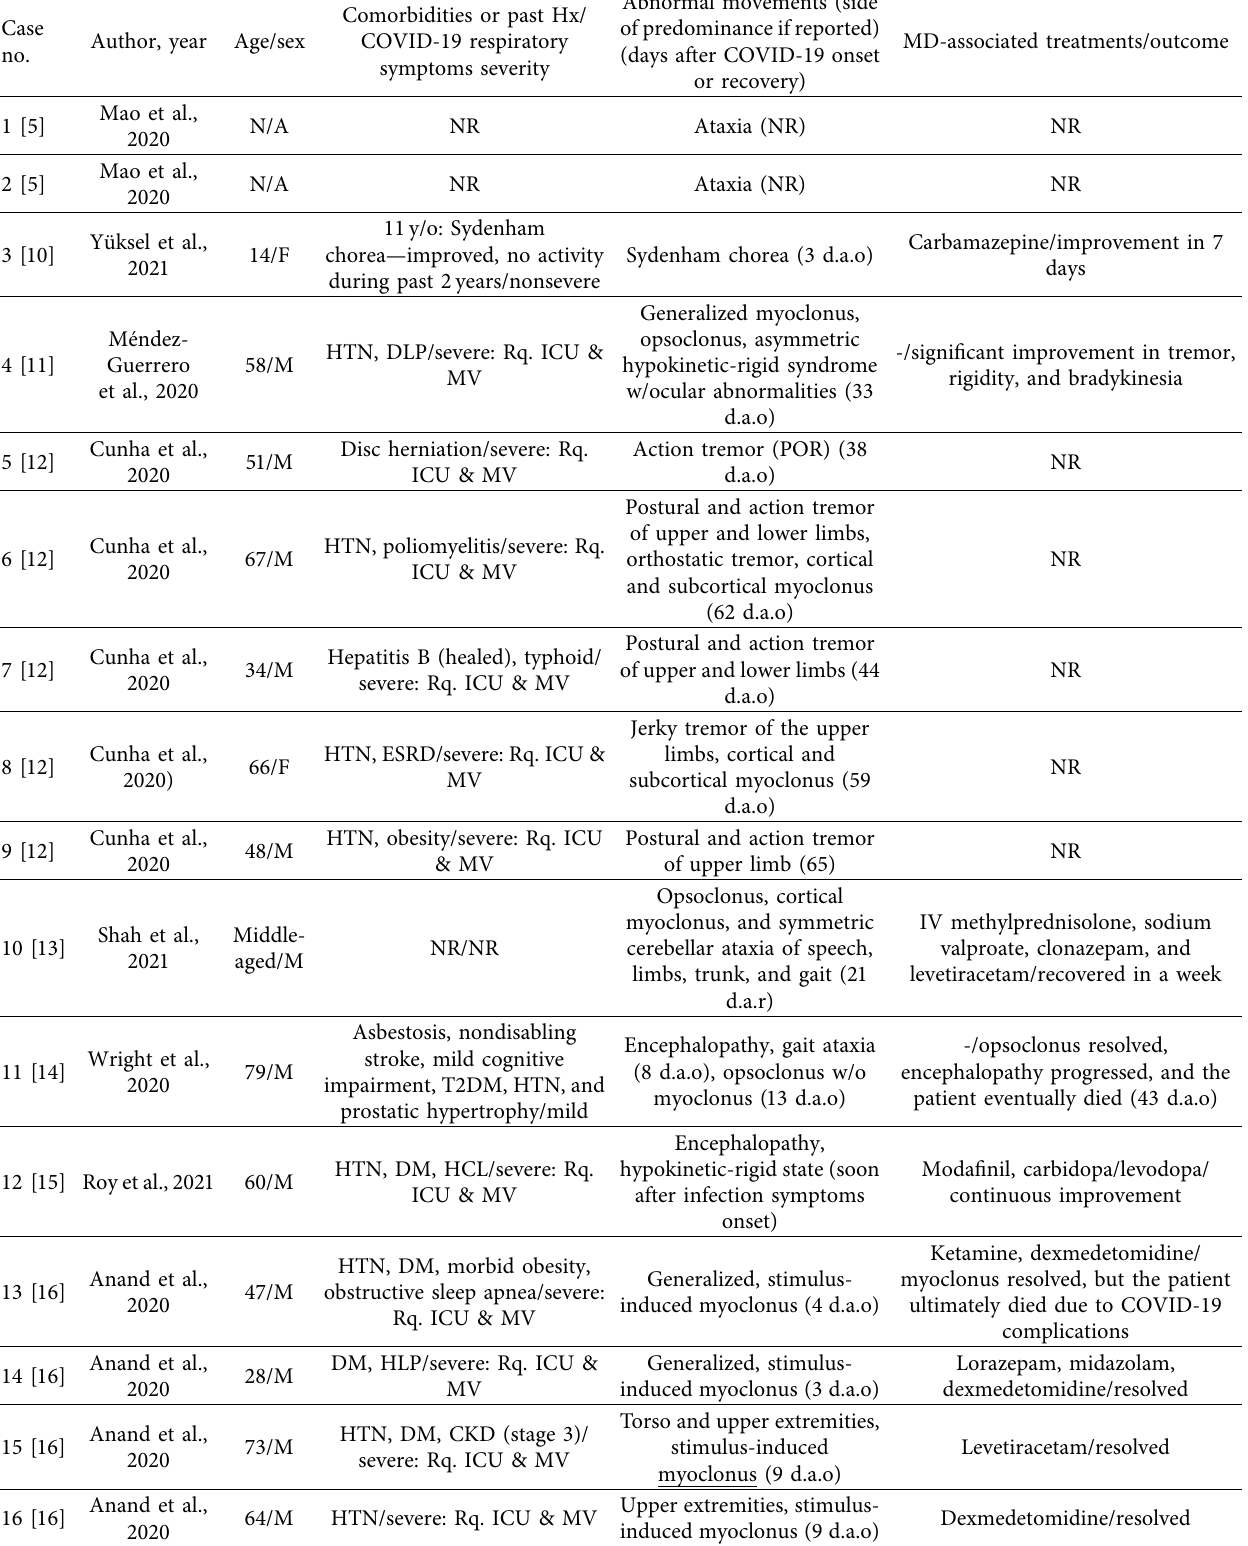
Table 1: Summary of demographic information and movement disorders associated with